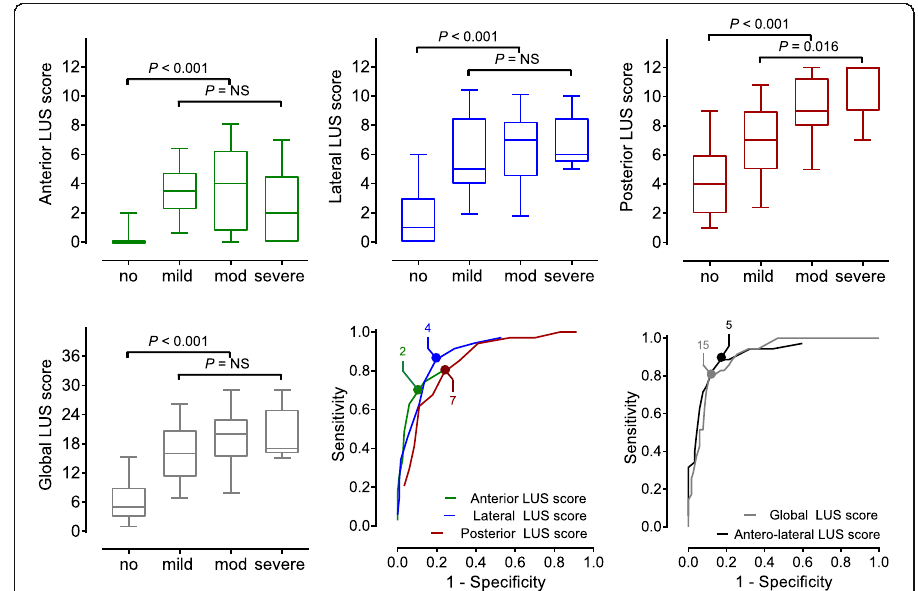
Fig. 2 Anterior, lateral, posterior, and global scores and the receiver operating characteristics curves (ROCs) for the diagnostic accuracy for the acute respiratory distress syndrome of the regional and composite scores. Boxes present interquartile ranges while whiskers show 10 to 90 percentiles. Dots in the ROCs represent the best cutoff, and used to calculate sensitivity, specificity, positive and negative predictive value.